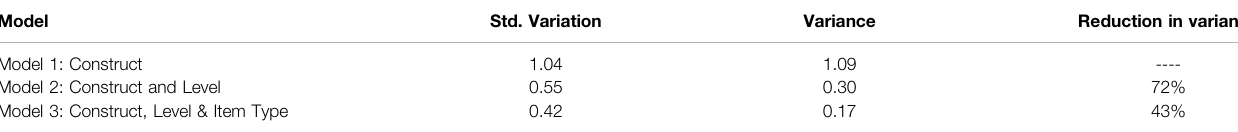
TABLE 6 | Random effects: Residual variances by model and fi xed effects of model 3. Model Std. Variation